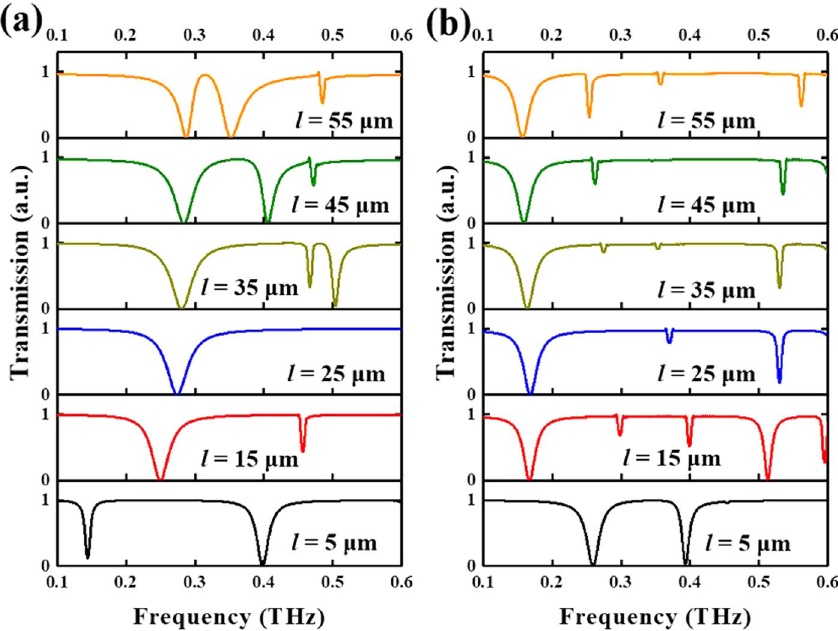
Figure 4. Simulated transmission spectra of CLM with different l value. Transmission spectra of CLM with different l value at ( a ) TE mode and ( b ) TM